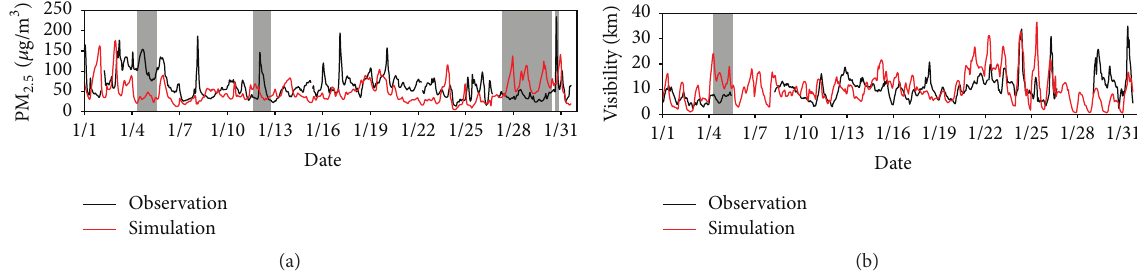
Figure 4: Comparison of simulated (a) PM 2.5 concentrations and (b) visibility with observations (the discontinuities are due to the missing observational data. The shaded areas in panel (a) denote 5, 12, 28–30, and 31 January mentioned in Section 3.2. The shaded area in panel (b) denotes 5 January).